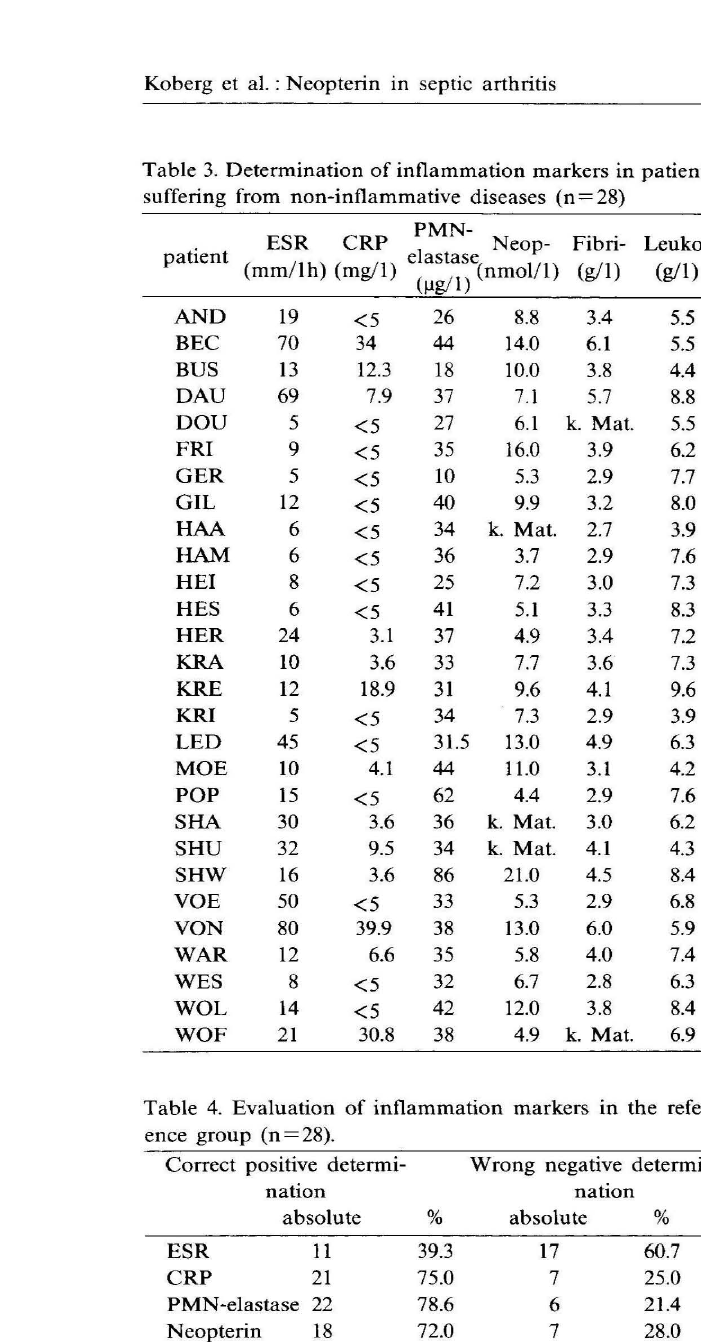
Table 3. Determination of inflammation markers in patients suffering from non-inflammative diseases (n=28) PMN-